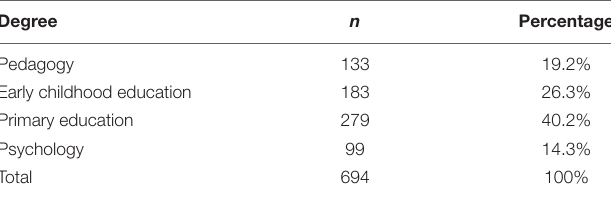
TABLE 1 | Distribution of students by bachelor